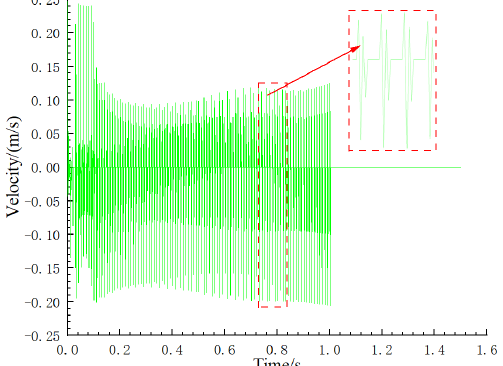
Figure 15. Acceleration curve of No.1 valve.